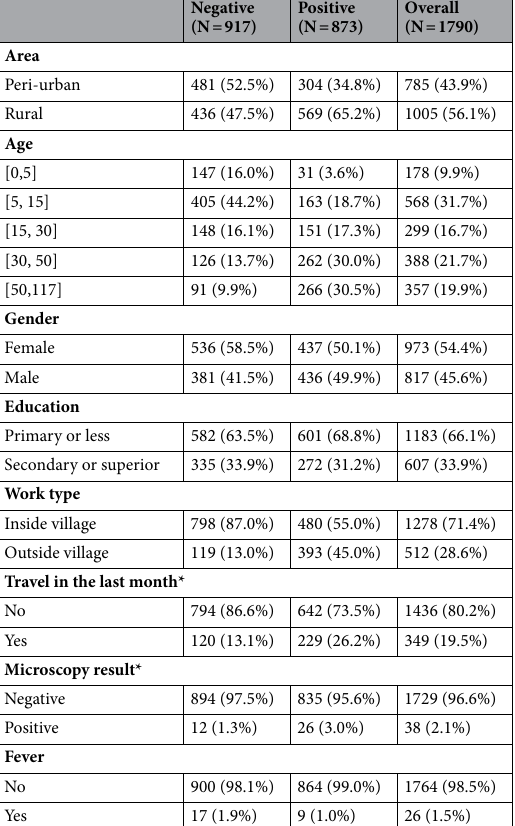
observed in relation to gender and education, however, contrasting patterns were observed in relation to outside (77%) in comparison to inside (38%) workers and recent travelers (66%) in comparison to no travelers (45%). The spatial distribution of the seropositivity rates is shown in Fig. 1A and Supplementary Fig. 1. A clustered pattern at the household level was observed in both study settings. Out of the 421 households surveyed in the peri-urban area, a seropositive individual was detected in 290 (68%) households, ranging from 55 to 82% at the village level. Conversely, in the rural setting, a seropositive individual was detected in 396 (94%) out of 419 households. Remarkably, at least one seropositive participant was detected in all households in GC and PE. The seroprevalence rates were further explored across age categories and different socioeconomic variables in Fig. 1B. In addition to the overall higher malaria exposure (seroprevalence) in rural than peri-urban areas, the age breakdown showed contrasting patterns between these areas. A smoother increase in the age-seroprevalence trend was observed in peri-urban areas. In contrast, an abrupt disruption at age 15 was observed in rural areas. It is important to notice that the age composition is different between rural/peri-urban areas (distinguished by the width of the bars), much younger in rural areas. Most noticeable differences in the age-structure and age-seroprevalence trend were observed between type of activities (inside/outside village) and recent travelers. Out-of-village working activities were carried out by the older population (> 30 years old) that showed high seroprevalence rates (> 60%). A similar pattern was observed for recent travelers, most of them were adults (> 30 years old) with very high seroprevalence rates (> 80%). The frequency distribution of out-of-village work- ing activities and seropositivity status is shown in Supplementary Fig. 2 and spatial distribution of household work out-of-village rate spatial distribution in the villages in the study area is shown in Supplementary Fig. 3. Average causal effect estimation. Using a parametric g-computation, this study estimated that the standardized mean outcome (malaria seroprevalence) in the unexposed population (i.e. if all participants do not carry out out-of-village working activities) is 44.6% (95% CI: 41.7%–47.5%) and 66.7% (95% CI: 61.6%–71.8%) in the exposed population (i.e. if all participants carry out out-of-village working activities) (Fig. 2). The role of out-of-village working activities on recent malaria exposure (seroprevalence) was estimated as the difference between these quantities (standardized mean outcome) in the exposed and unexposed. This results in an impor- tant and precise average causal effect with a risk difference of 22.1% (95% CI: 16.3%–27.9%).